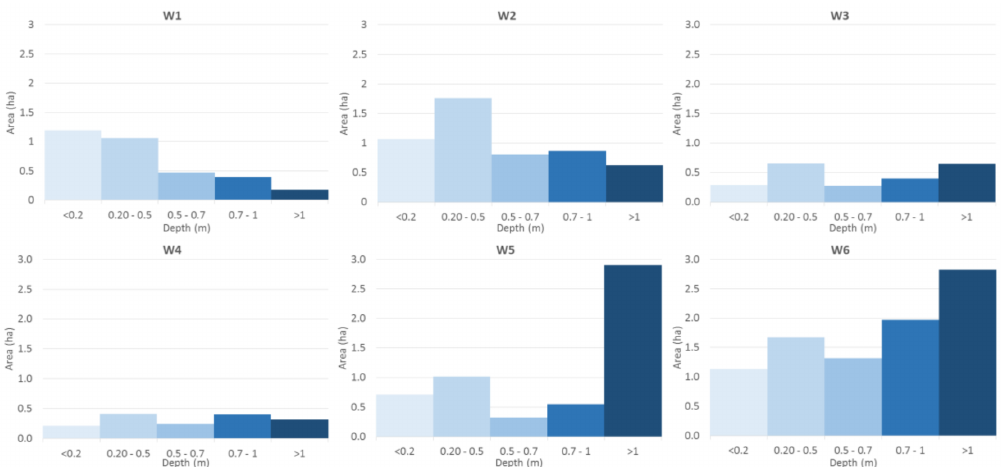
Figure 6. Histograms of the wetland depth distribution in the six potentially suitable wetland areas. Locations of the areas are shown in Figure 7.